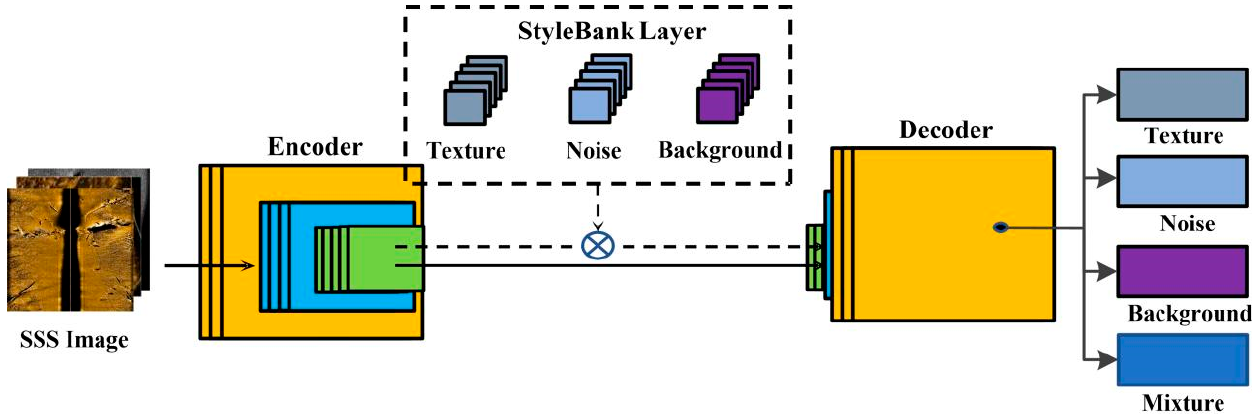
Figure 10. StyleBankNet network